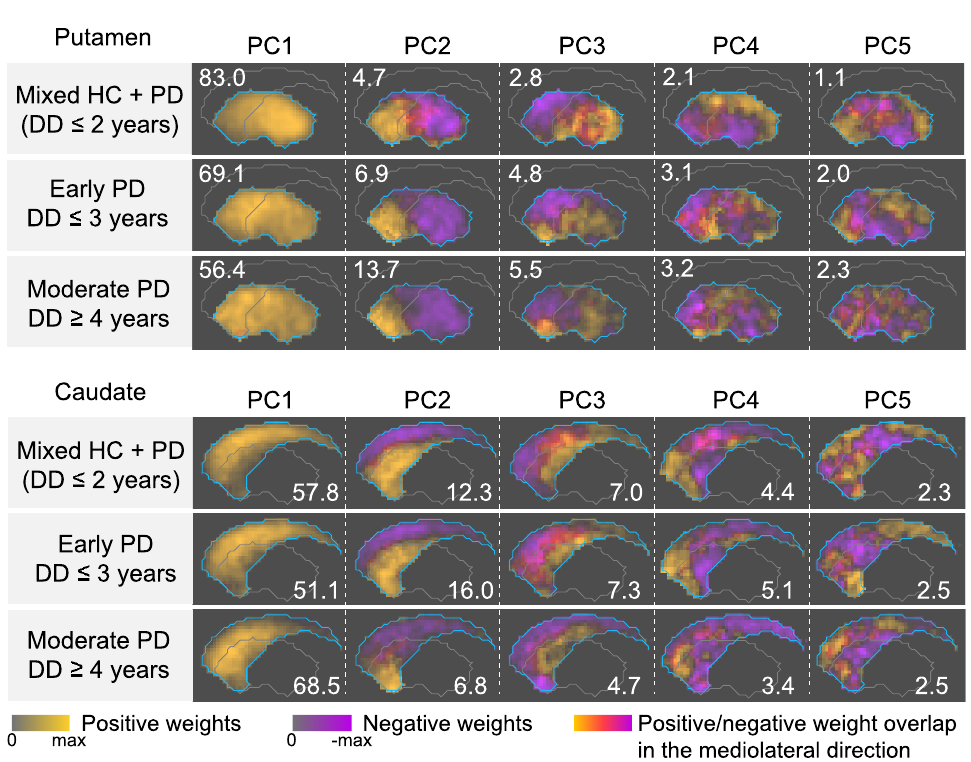
Fig 4. Maximum intensity projections of the better-side DTBZ PC loadings, obtained from PCA of subject sub- groups at different stages of the disease. The PCs are ordered according to VAF expressed in percent (shown in the corners). PC loadings in the putamen and caudate were computed separately. The first rows of the putamen and caudate loadings (mixed HC+PD) capture patterns associated with the initial onset of clinical PD symptoms. The second rows (early PD) represent stage of the disease shortly after symptom onset. The third rows (moderate PD) correspond to later stage of the